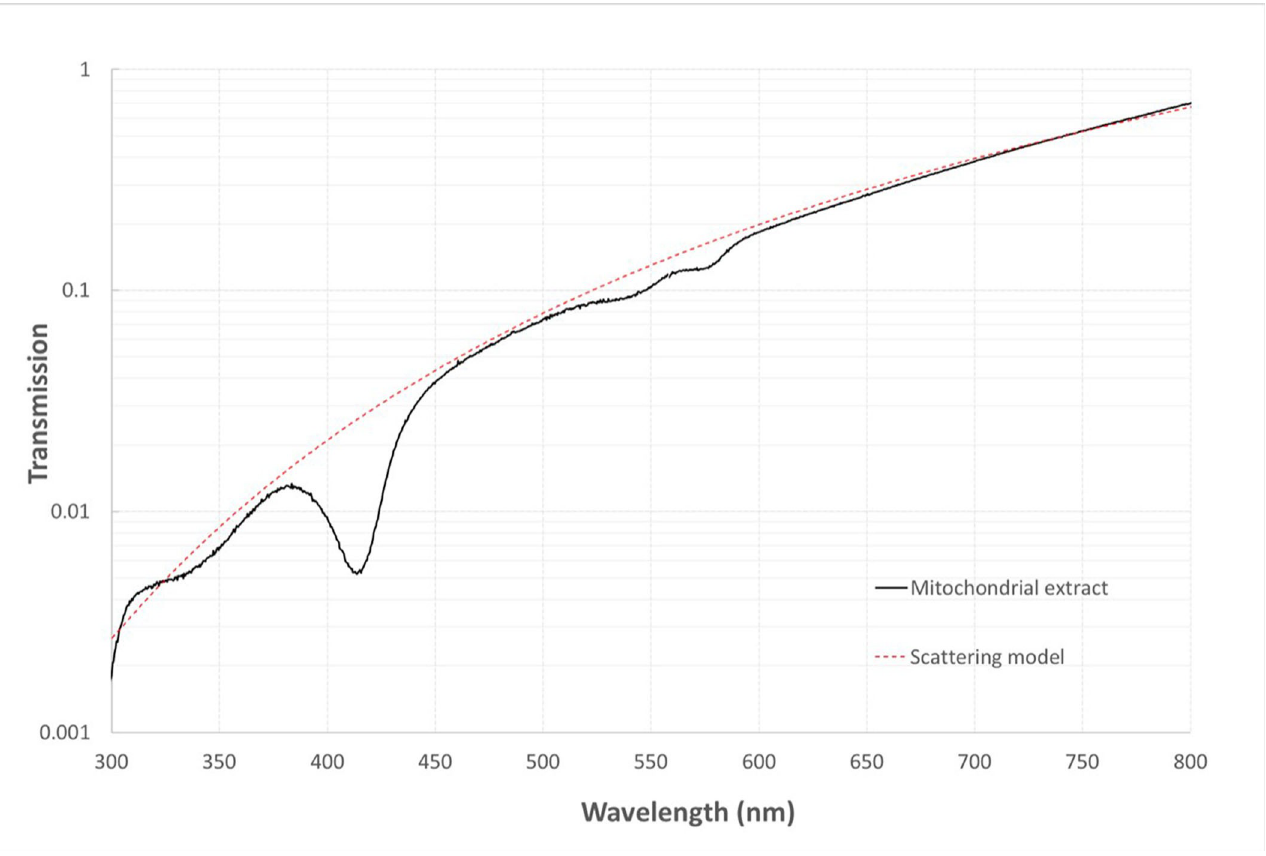
Fig 1. Shows the 1cm cuvette sample transmission spectrum (black line) from two separate measurements of mitochondrial transmission taken from extract of mouse liver made using a deuterium and quartz-halogen lamp. The longer wavelength spectrum has been aligned in transmission with the UV measurement to account for the particulate settling in the sample. The dashed red line shows a simple wavelength power-law scattering model that can be used to correct the spectrum for this absorption-band free spectral component.